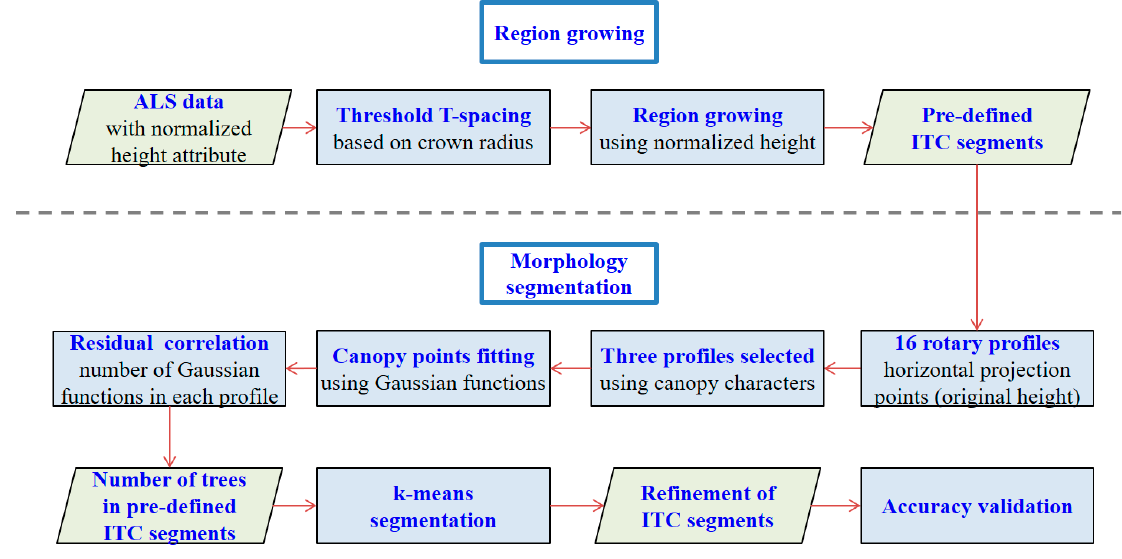
Figure 3. Workflow of the proposed method.